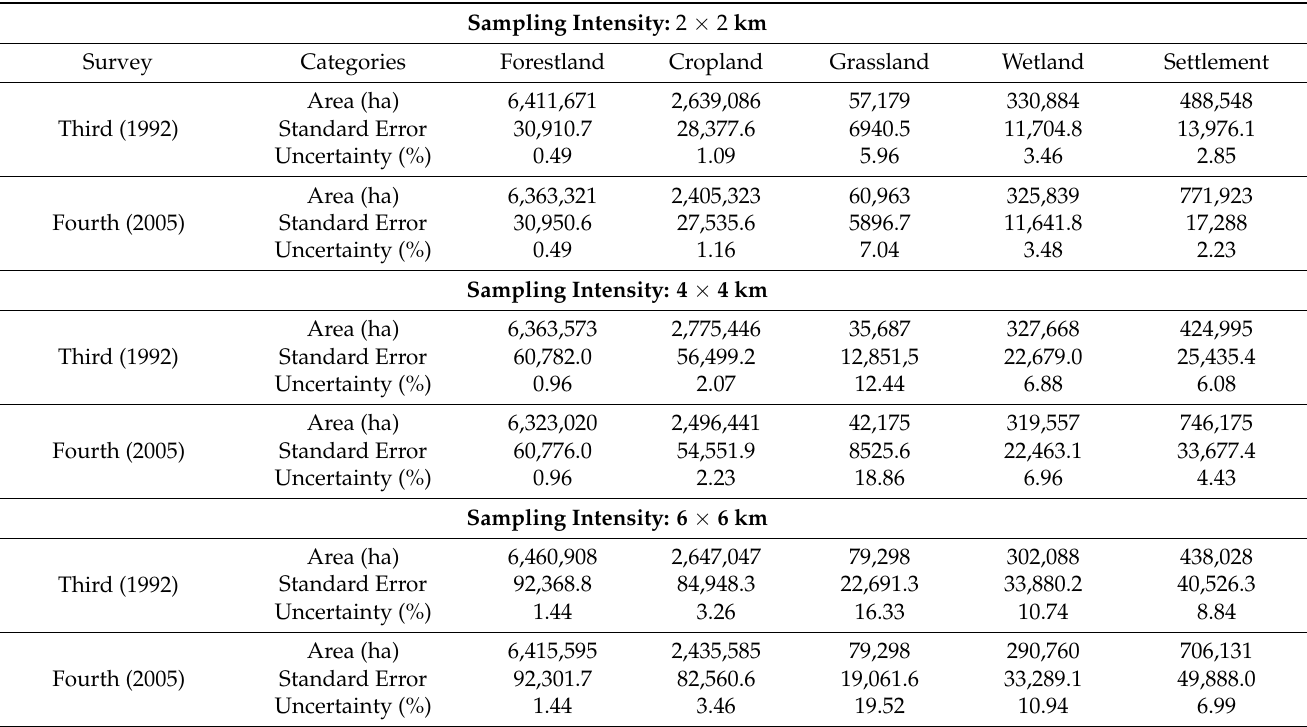
Table 4. Comparison of categorical land-use areas, standard deviations, and uncertainty estimates by examined aerial imagery and sampling intensity.